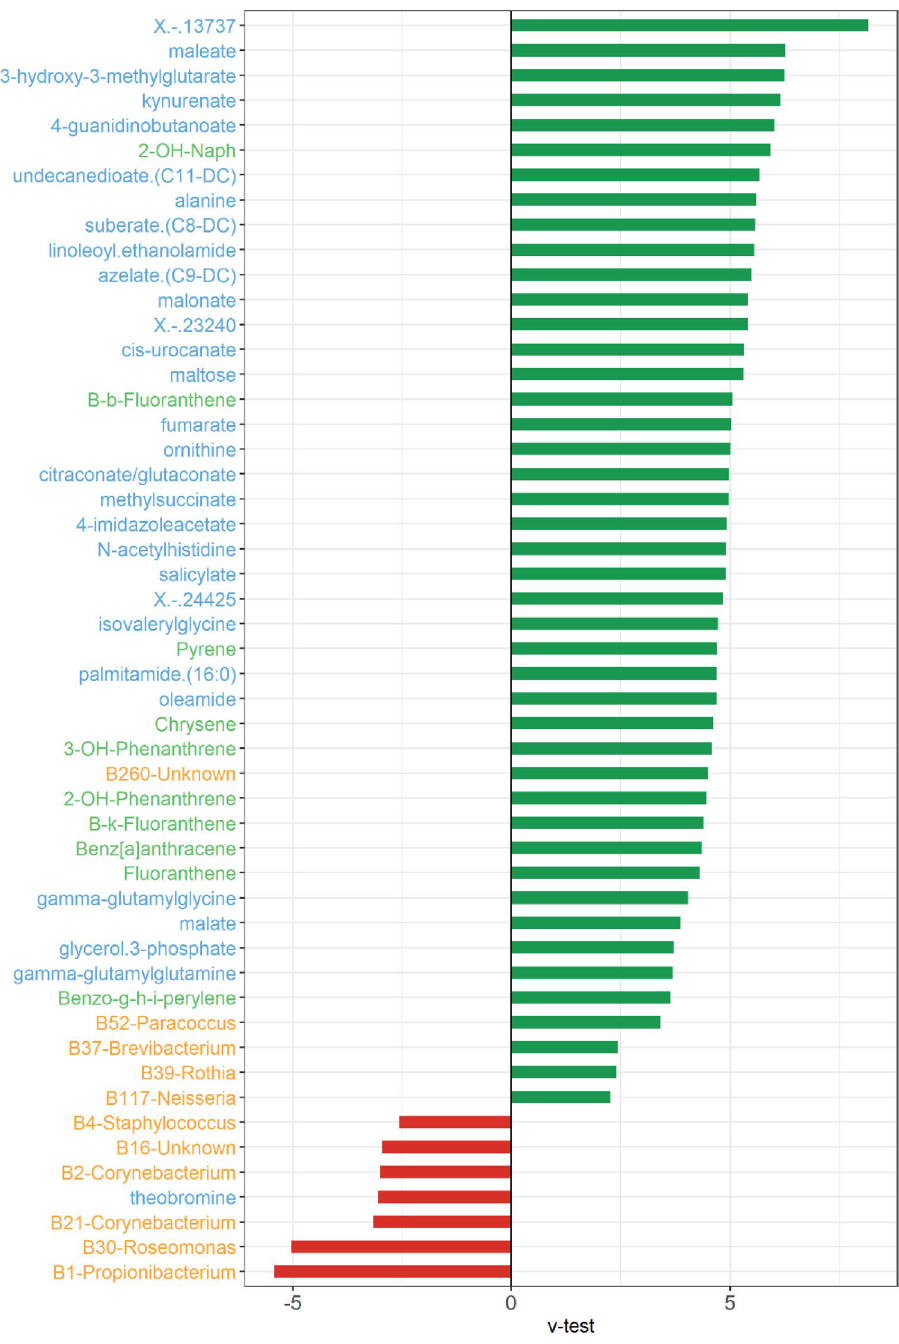
Figure 8. Focus on the characterization of the consensus cluster 1 by PAHs, metabolites and bacteria OTUs using v-test statistic. A positive v-test value (in green) indicates that the variable has mean value in the cluster higher than the global population. A negative v-test value (in red indicates that the variable has an average lower in the cluster higher than the global population. Only the variables with a significant v-test value are represented. The y-axis text is colored by type of variable (blue for metabolites, green for PAHs and yellow for bacterial OTUs). Figures were created using the R software: R Core Team (2017), R Foundation for Statistical Computing, Vienna, Austria. URL https:// www.R- proje ct.